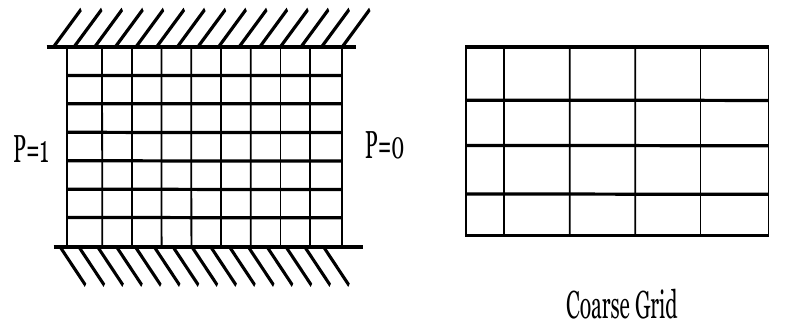
Figure 4. Global method for upscaling conditions.